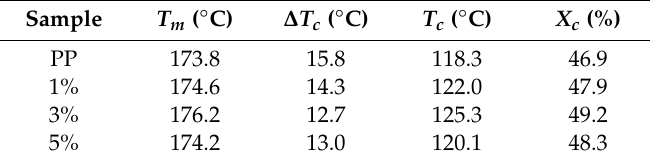
Table 1. Isothermal crystallization and melting process parameters of different nano ‐ MgO/PP and PP specimens.